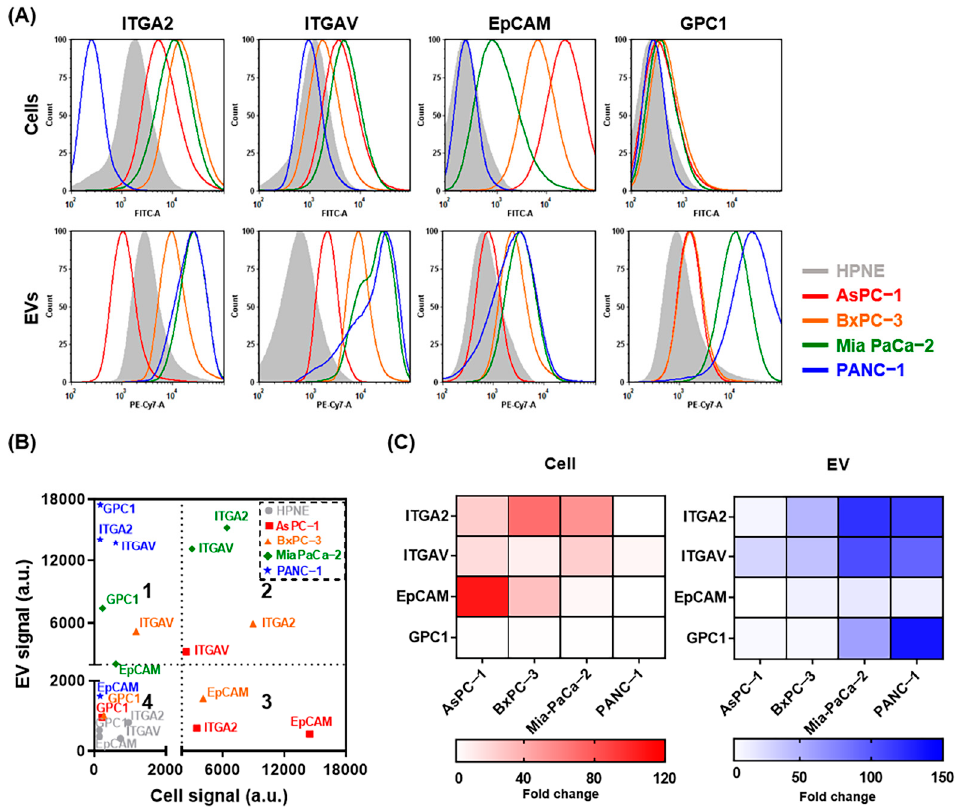
Figure 2. Characterization of pancreatic cancer-associated surface markers on the surface of cells and EVs. ( A ) Representative fluorescence-activated cell sorting (FACS) histograms of ITGA2, ITGAV, EpCAM, and GPC1 expression on cells (upper) and EVs (lower) using Alexa Fluor 488 and PE-Cy7 − labeled antibodies. ( B ) Correlation between surface marker expression on cells (x-axis) vs. EVs (y-axis). Dotted cutoff lines are shown at the mean fluorescence intensity (MFI) value of 2000. ( C ) Heat map of surface marker expression in pancreatic cancer cells (red) and EVs (blue) compared with the normal pancreas control cell line HPNE.